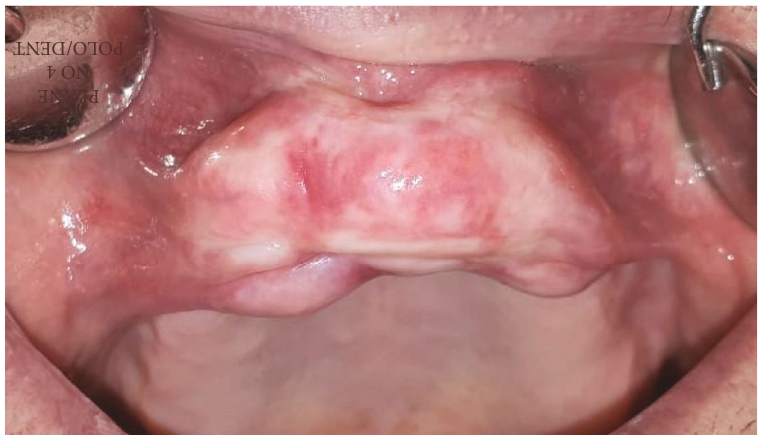
Figure 1: Slow-growing painless mass.